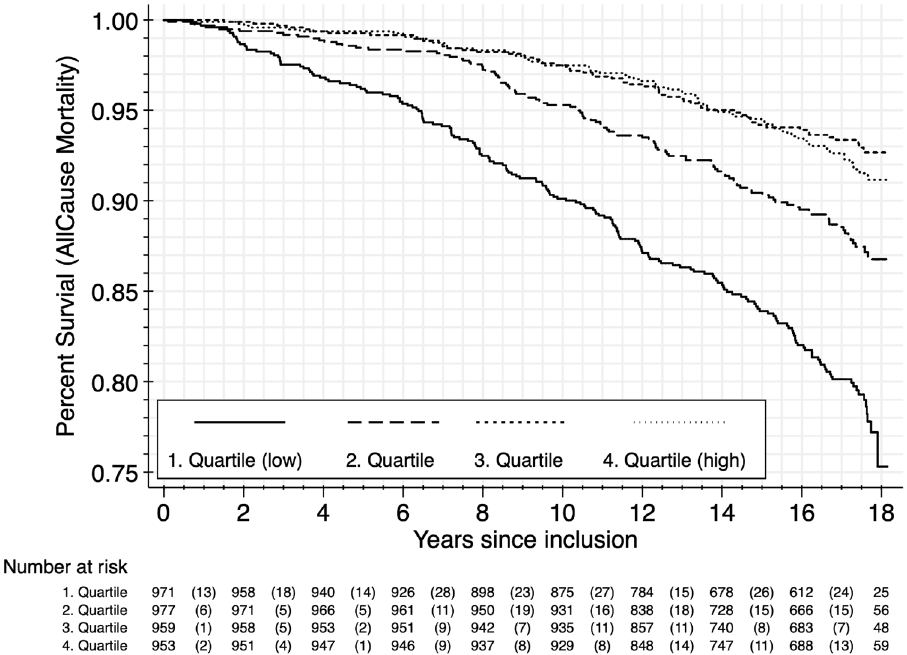
Figure 1. Kaplan–Meier survival function by NIM IL6 quartile (Observations N = 3860, No. of deaths = 429). At the End of the observation period (18 years) 75% survived in the belonging to the lowest quartile of NIM-Ratio (0.666–0.969) and 91% survived in the highest quartile of NIM-Ratio (1.033–1.996) (Log-rank test for equality of survivor functions: chi 2 (3) 108.64; p <